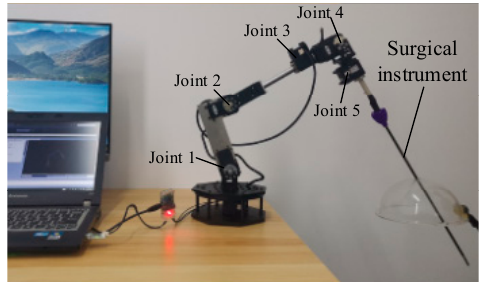
Figure 10. Slave manipulator used for force control implementation.